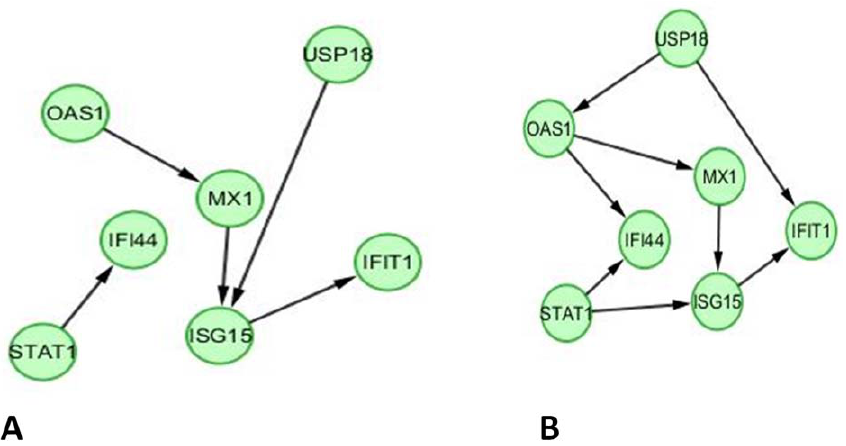
Figure 5. Discovered Bayesian Network for the full set of GBM (A) and the Proneural subtype (B). Growth-shrink algorithm was used and 80% bootstrap support for presence of edges and 50% bootstrap support for edge direction were required for the full sample (A), and 50% each were required for the Proneural subtype (B). With the more stringent criteria for the Proneural subtype (80% bootstrap support for edge presence) the OAS1- . MX1 and ISG15- . IFIT1 edges were discovered.